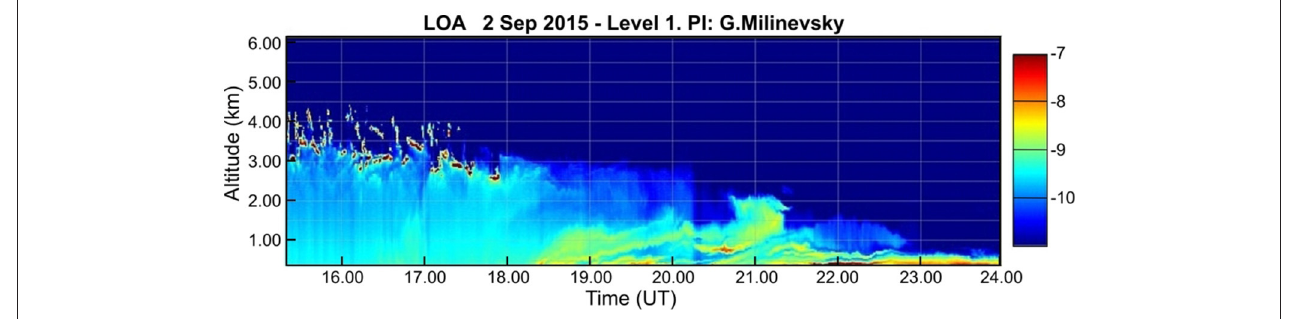
FIGURE 7 | Corrected by altitude lidar signal in logarithmic scale shows arrival in the area at 18:20UT of the strong aerosol smoke altitude distribution and dynamics over Kyiv AERONET site by lidar measurements. particles has higher values 70–100 sr at 532 nm wavelength (Ansmann and Muller,